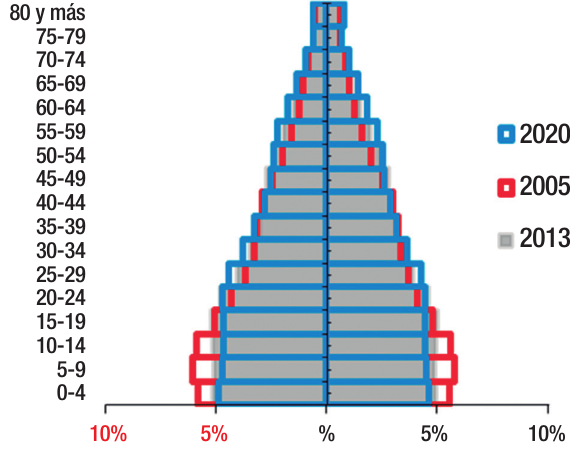
Figure 1. Population pyramid, Department of Huila, 2005, 2013,